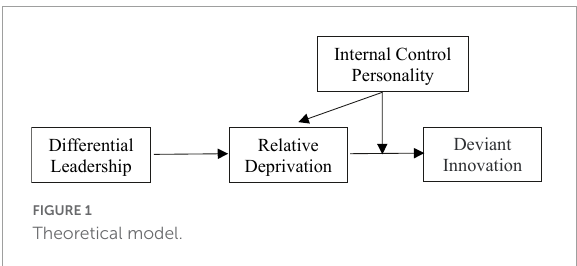
FIGURE1 Theoretical